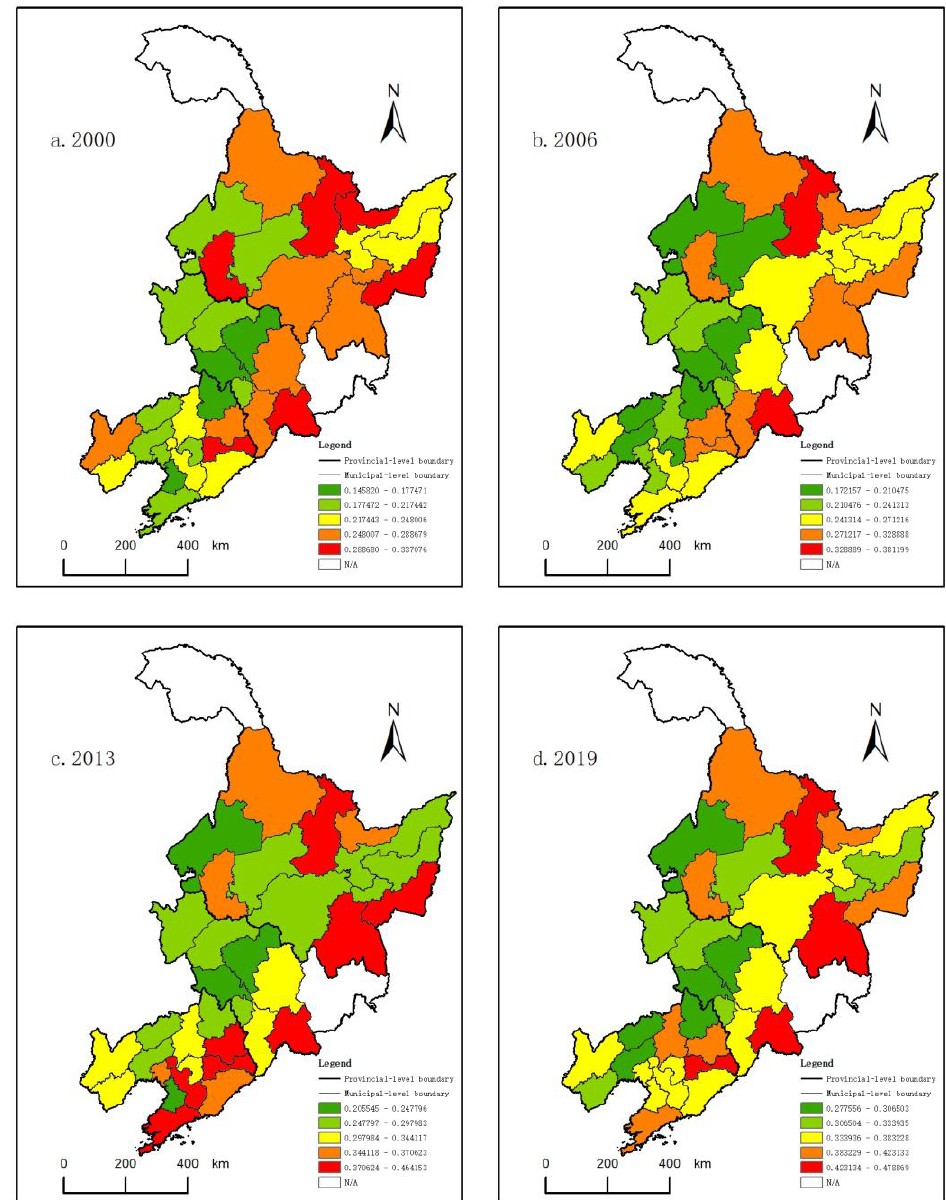
Figure 6. Spatial Distribution of Rural Development Levels in Northeast China. ( a ) 2000; ( b ) 2006; ( c ) 2013; ( d ) 2019.